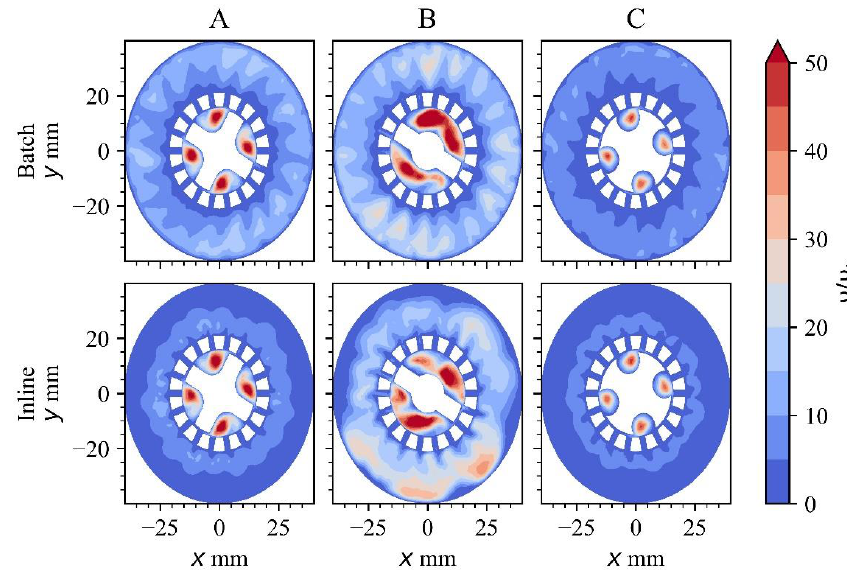
Figure 6. Kinematic turbulent viscosity ratio contours along the plane z = 13 mm.